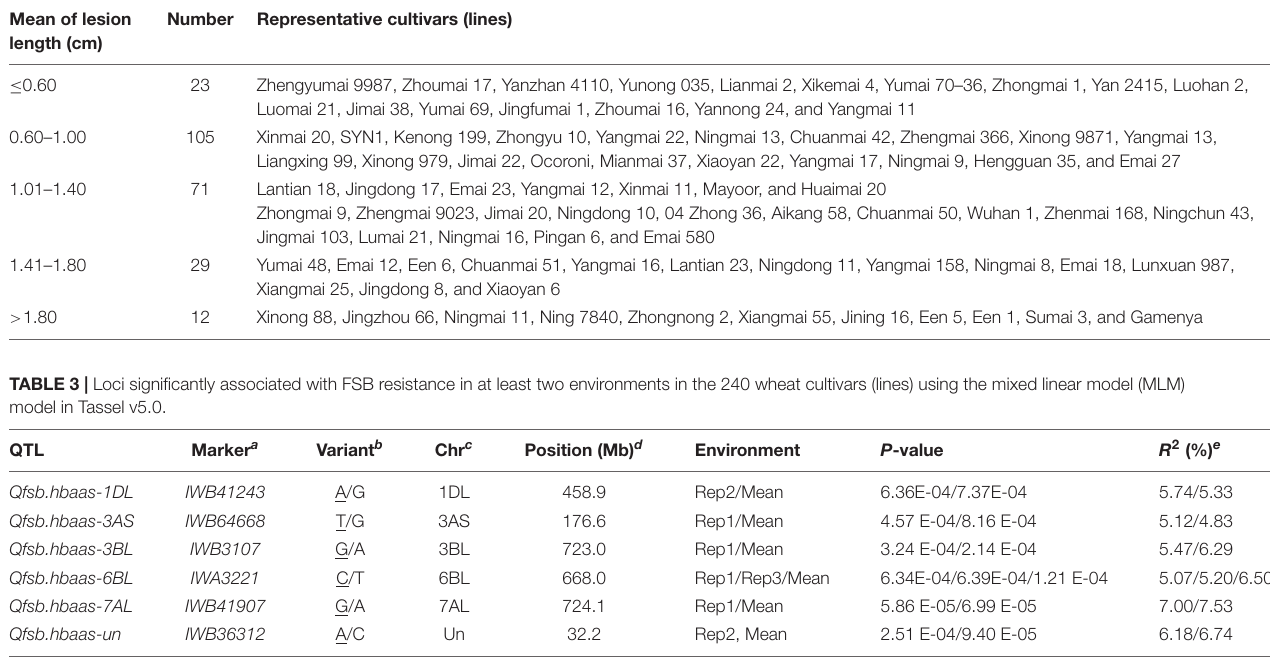
a Representative markers showing the strongest association with the FSB resistance locus. b Favorable allele is underlined. c Chr, chromosome. d Physical positions based on the Chinese Spring reference genome sequences from the International Wheat Genome Sequencing Consortium (IWGSC, http://www.wheatgenome.org). e Percentage of phenotypic variance explained.